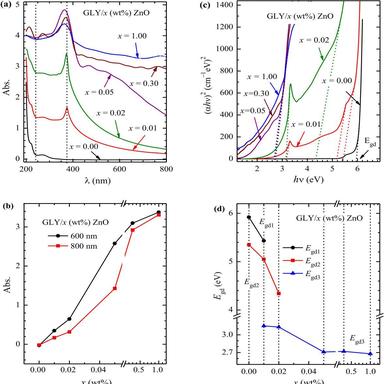
(a) UV–Vis absorbance spectra of GLY/x (wt%) ZnO nanofluids (x = 0.00, 0.01, 0.02, 0.05, 0.30, and 1.00), (b) plots of absorbance (Abs.) versus x (wt%) of ZnO for the nanofluids at fixed wavelengths (i.e., k = 600 nm and 800 nm), (c) Tauc plots ((ahm) 2 versus hm) of the nanofluids showing the extrapolated dashed lines for determination of various direct energy band gap (Egd) values, and (d) plots of energy band gaps (Egd) versus x (wt%) amounts of ZnO for the nanofluids.